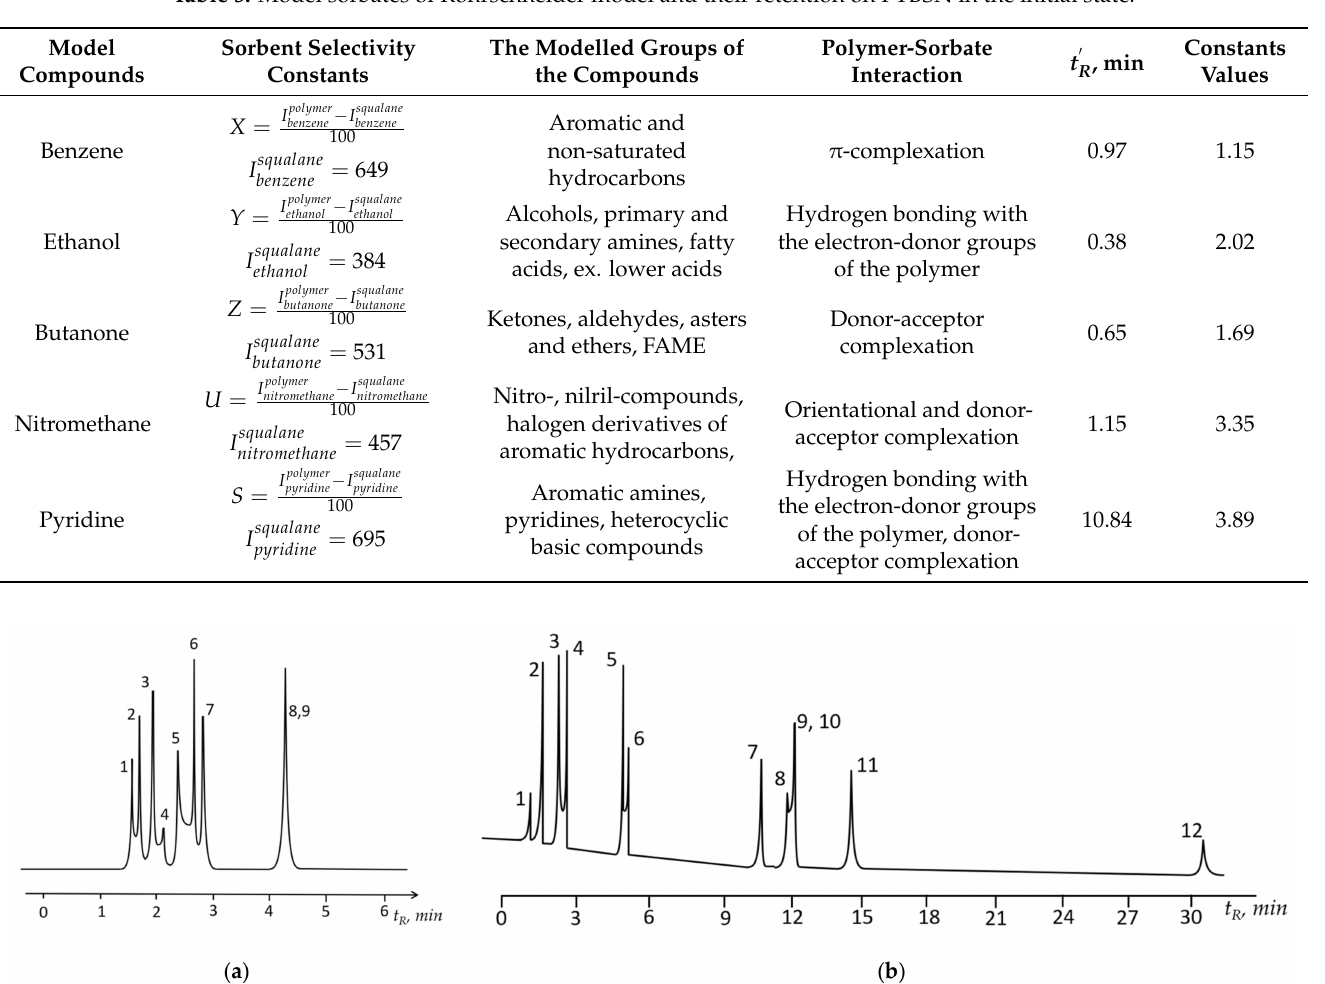
Figure 8. Separation of model mixtures on PTBSN stationary phase column in the initial state. ( a ) 1—ethanol, 2—n-hexane, 3—benzene, 4— n -butanol, 5—nitromethane, 6— n -octane, 7—toluene, 8— m -xylene, 9— p -xylene. Carrier gas helium, P